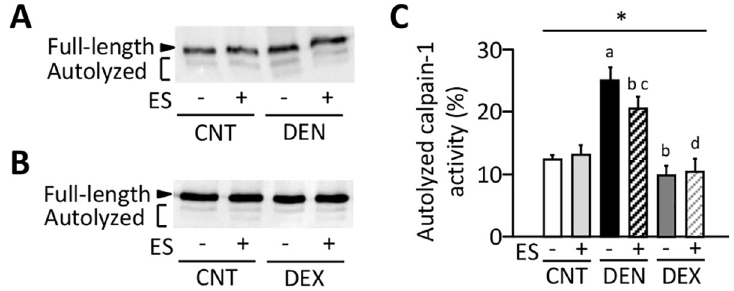
Fig 7. Neuromuscular electrical stimulation (ES) training prevents the activation of calpain-1 in DEN muscles. Representative western blots illustrating the autolysis of calpain-1 of gastrocnemius muscles in control (CNT), denervation (DEN), dexamethasone (DEX) rats with or without ES training ( A, B ). The content of autolyzed calpain-1 was expressed as a percentage of the total calpain-1 in the same muscle sample ( C ). Bars show the mean and SEM results from 5–9 muscles per group. Statistical significance was set at P < 0.05: main effect of � treatment (i.e., DEN and DEX); difference versus a CNT, b DEN, c CNT+ES, and d DEN+ES.